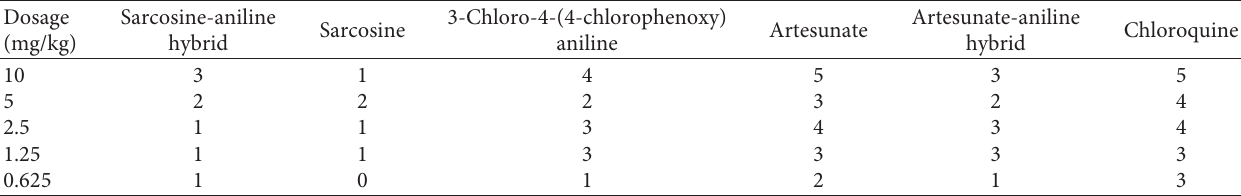
Table 4: Survival rate after 11 days of in vivo efficacy testing.